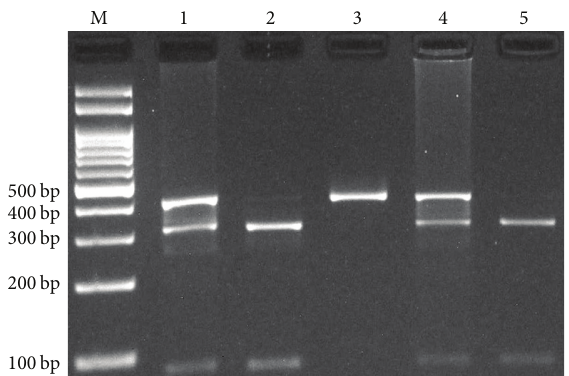
Figure 1: Photograph of the PCR products of HLA-G +3142G > C polymorphism by polymerase chain reaction-restriction fragment length polymorphism method (PCR-RFLP). G allele digested by BaeGI restriction enzyme and produced 316 bp and 90 bp while C allele undigested 406 bp. M: DNA Marker; Lanes 1 and 4: GC; Lanes 2 and 5: GG; Lane 3: CC.